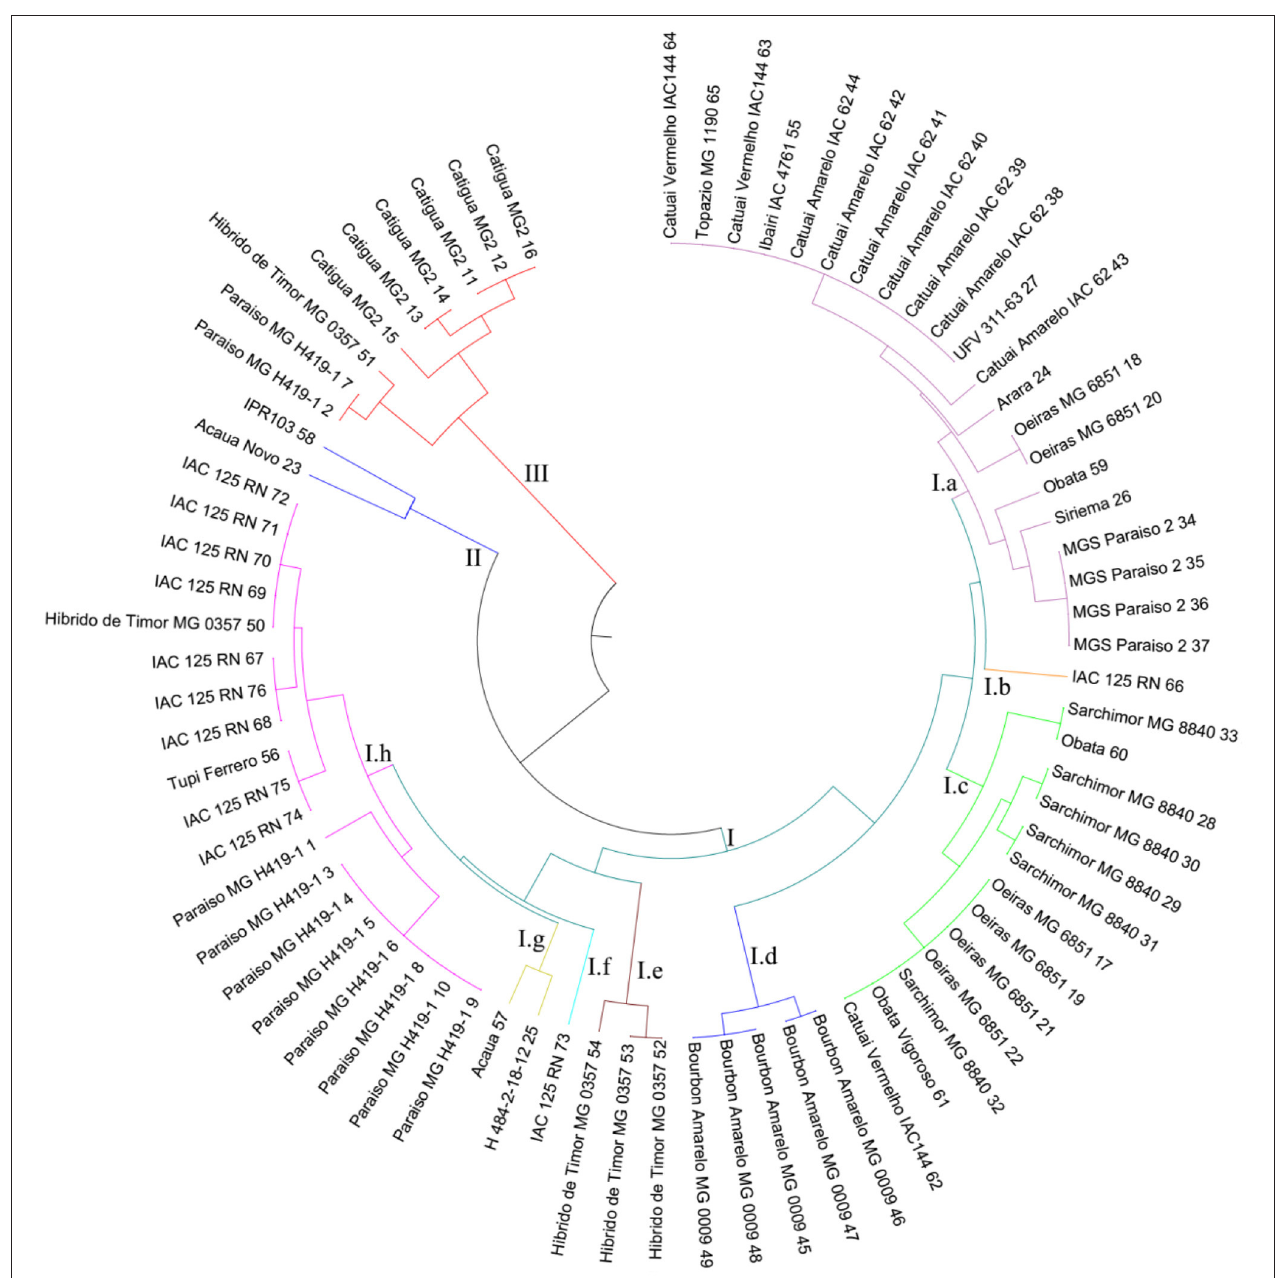
FIGURE 2 | Dendrogram based on the analysis of 12 SSR markers in 76 coffee trees ( Table 1 ), obtained by the UPGMA technique, using the dissimilarity matrix of the weighted index arithmetic complement.